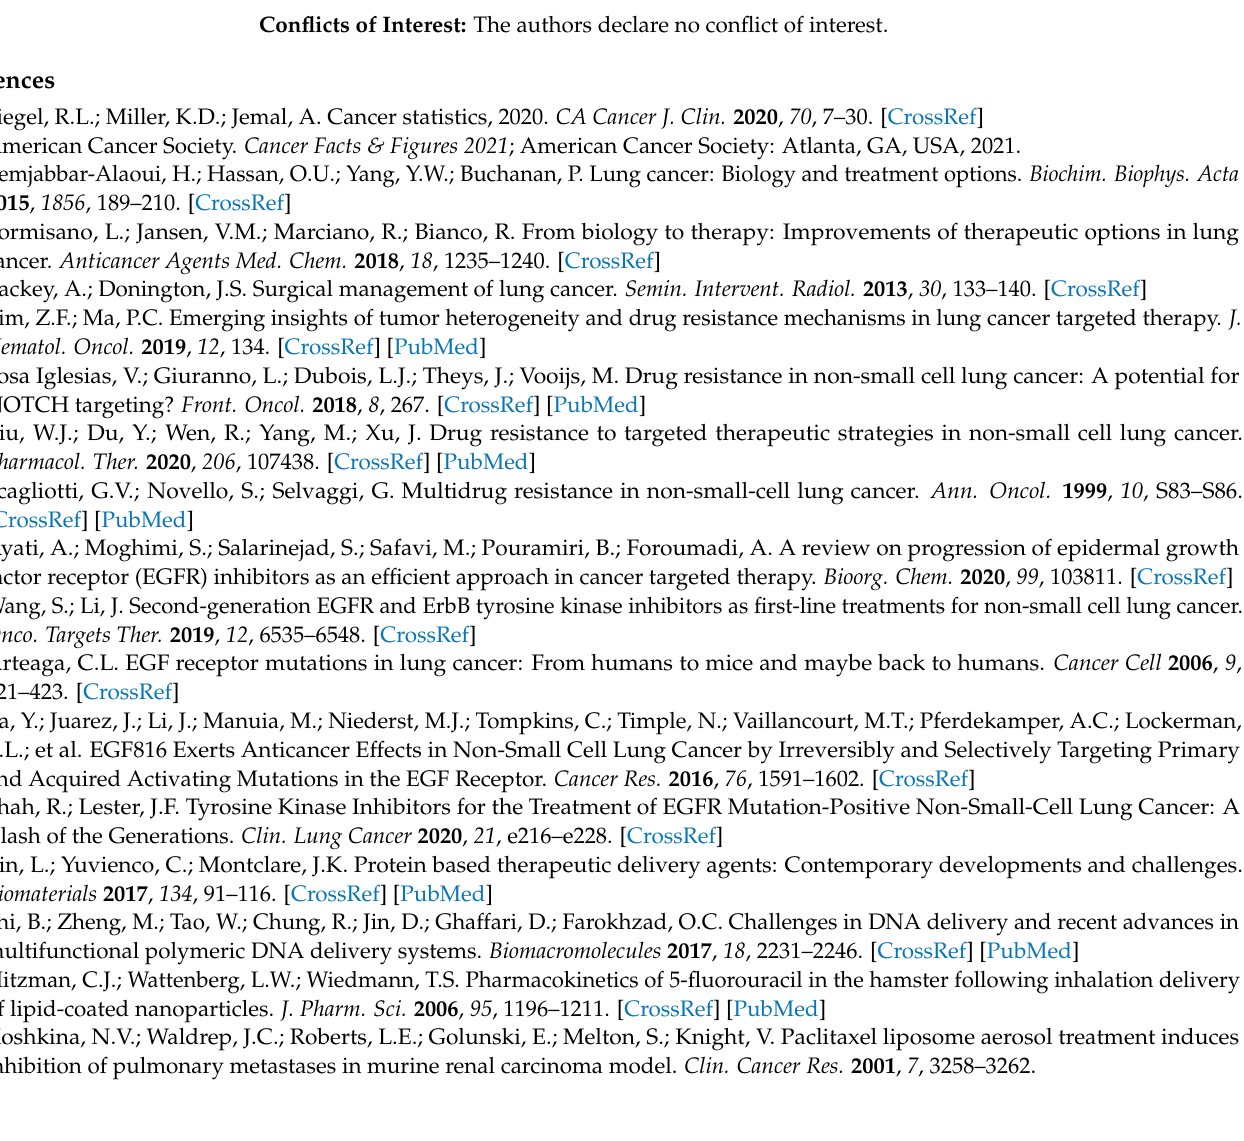
PEG–LHRH peptide; Figure S2: Size distribution profile of the NLC formulations in aqueous phase; Figure S3: HPLC traces (retention time in minutes) of gefitinib (GEF) and paclitaxel (PTX) in standard sample and in the corresponding NLC formulations; Table S1: Stability of the NLC formulations under storage in RPMI-1640 culture